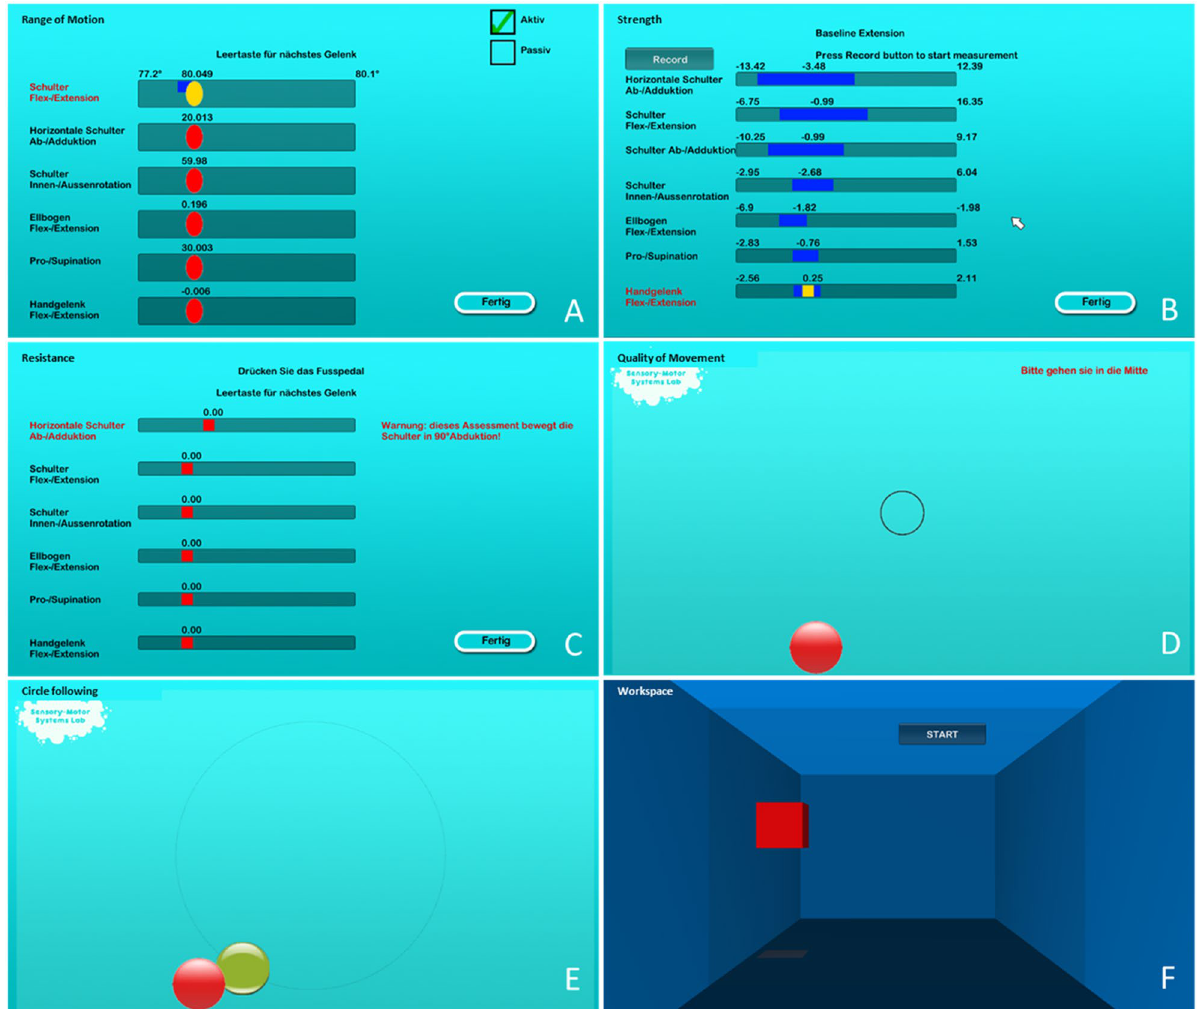
Figure 2. Interfaces of the assessments. ( A ) Active and passive Range of Motion. ( B ) Isometric Strength. ( C ) Resistance to Passive Movement. ( D ) Quality of Movement: eight targets appearing radially around the centre point need to be reached. After each target, the participant has to return to the centre position. ( E ) Circle following: the green ball moves in a circle and the participant is instructed to position the red ball as exactly as possible on the green ball throughout the circular movement. ( F ) Workspace: the participant is instructed to make the virtual room on the screen as large as possible by pushing with the red block against each wall (in forward, backward, left and right direction, respectively), the ceiling upwards and the floor downwards. The block represents the position of the wrist and is steered by moving the arm in the according We subtracted the resistance [Nm/rad] measured at slow velocity (10°/s) from the resistance obtained at high velocity (60°/s) to determine the amount of velocity-dependent increase in muscle tone 18 in line with the definition of spasticity). (e) ‘QoM’ measures the quality of goal-directed movements. The child was asked to move the hand from the centre point on the screen to one of eight different target points appearing one after the other, radially around the centre. After reaching a target, the cursor had to be moved back to the center before a new target appeared. The child performed the task three times. Six parameters, previously described in 14 , quantify aspects of movement quality. Movement efficiency is reflected by two parameters: The distance-to-path-ratio [unitless] is the quotient between the direct distance from the start to the target position and the actual length of the path that the patient was taking. The mean standard deviation [m] was calculated from the end-effector position during the 2 s on the target. Movement fluency is reflected by the mean number of peaks in the end-effector speed profile [n speed peaks/distance] and mean absolute number of speed peaks [n] as described in 14 . Temporal components are reflected by the mean time [ms] to reach the target and the mean reaction time [ms] which is the time from initializing the movement and leaving a threshold circle, 20% wider than the starting position 14 .